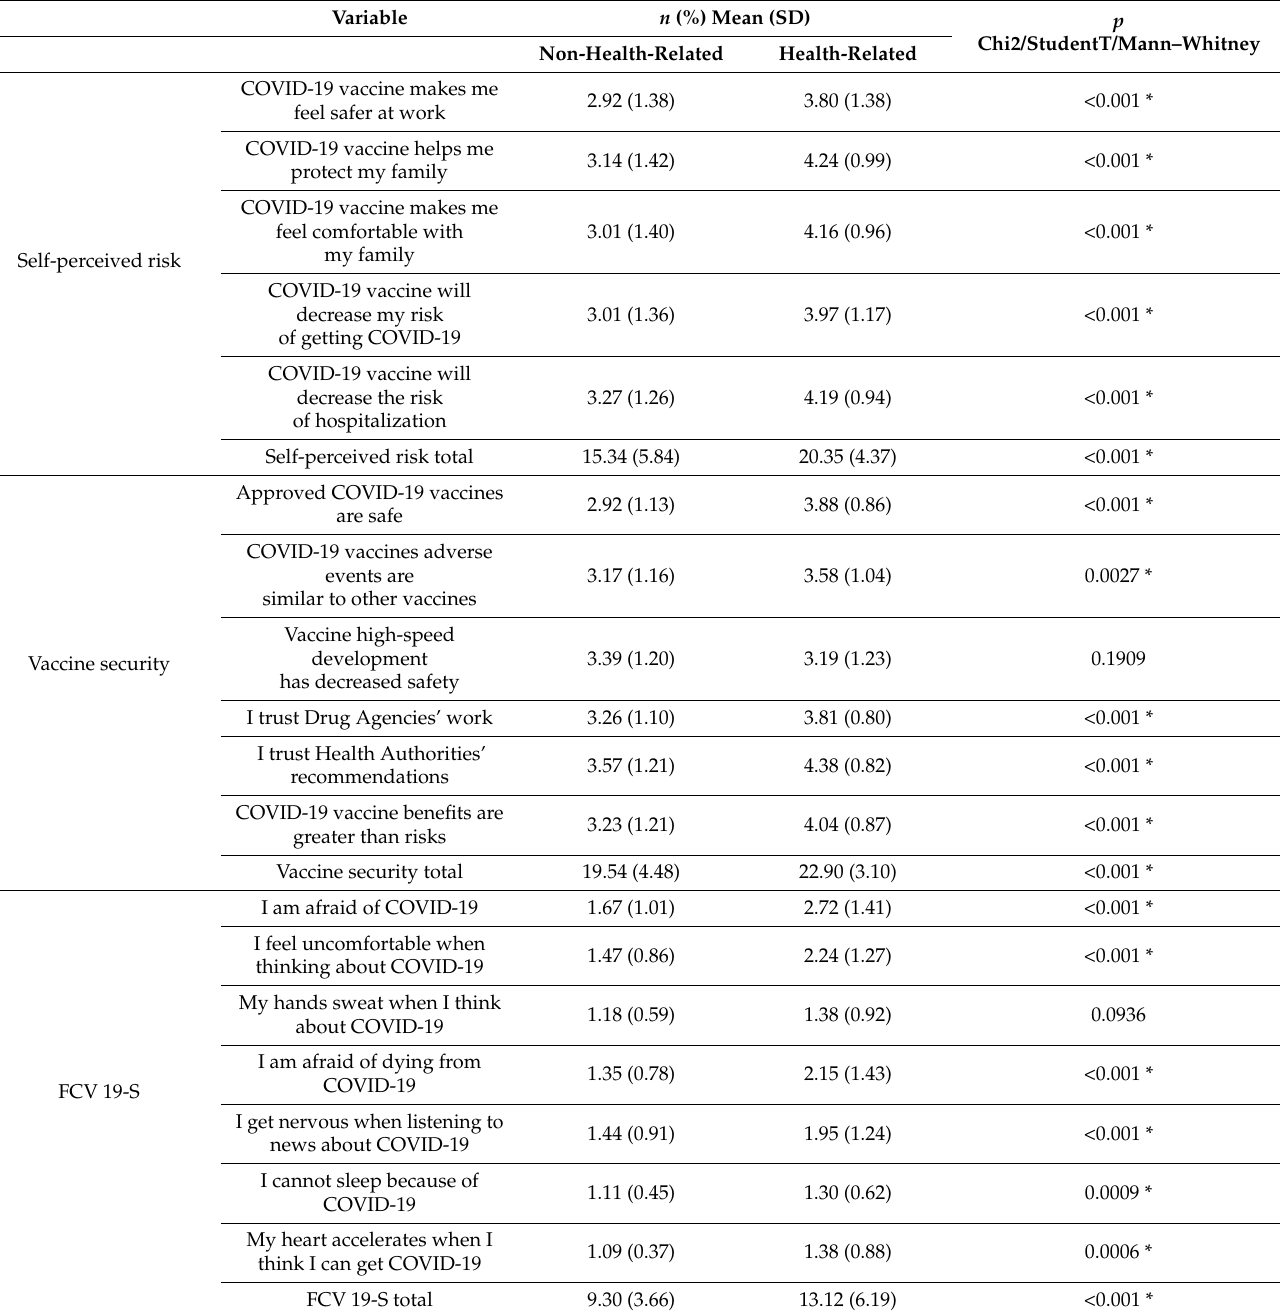
Table 3. Bivariate analysis by reason for vaccination (self-perceived risk, vaccine security, FCV 19-S).